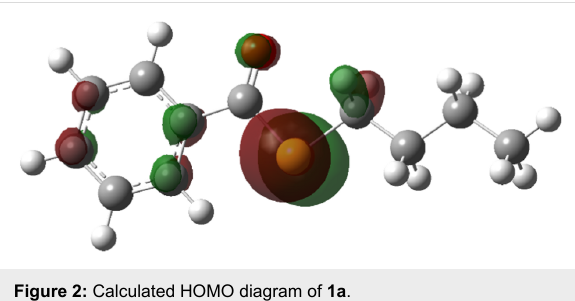
Figure 2: Calculated HOMO diagram of 1a